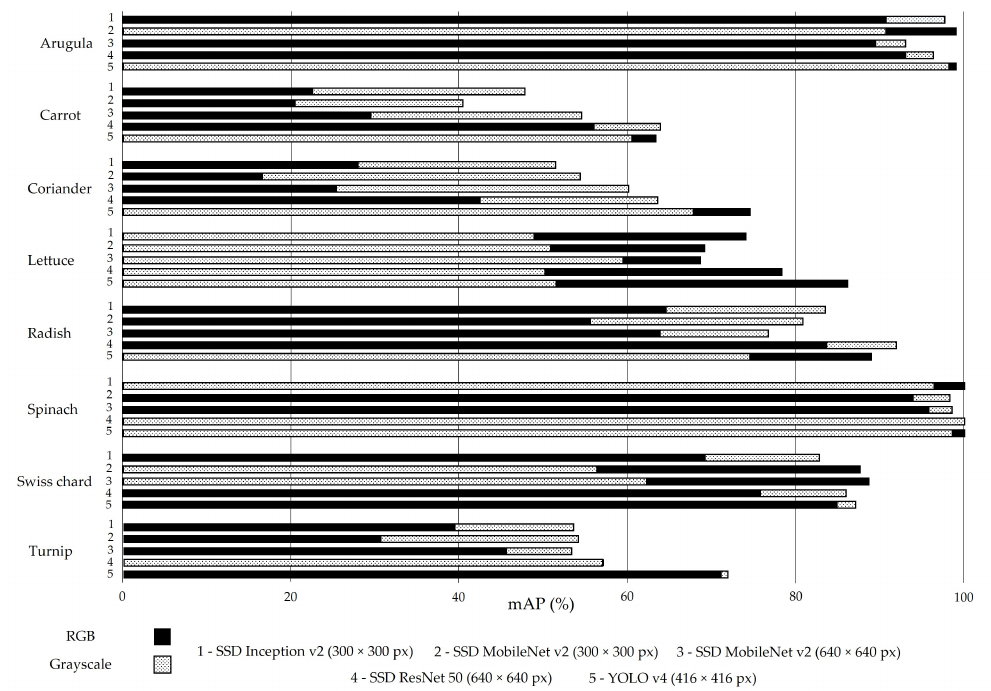
Figure 3. Mean average precision (mAP) for all models trained with RGB (solid black bars) and greyscale (dashed bars) images in the test set without